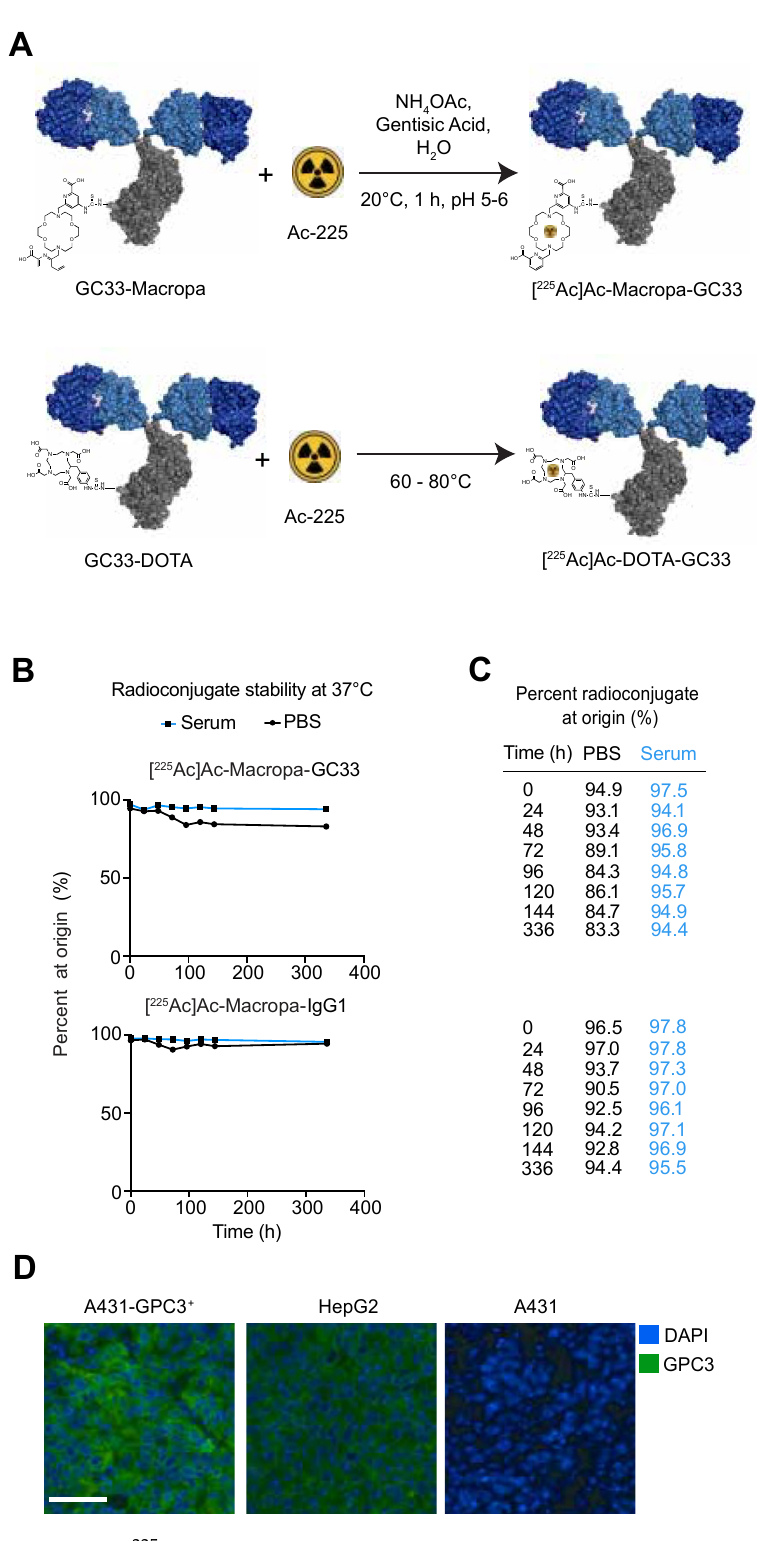
Figure 1. 225 Ac-labeled Macropa radioimmunoconjugates are stable in serum over time. ( A ). Schema for one-step Ac-225 labeling of antibody radioconjugates underscores that, unlike DOTA, Macropa chelation can occur at room temperature. ( B , C ). [ 225 Ac]Ac–Macropa–GC33 and [ 225 Ac]Ac– Macropa–IgG1 are stable in human serum and PBS at 37 °C up to 336 h after radiolabeling as measured by thin-layer chromatography and percent of activity at origin. ( D ). Immunofluorescence staining for GPC3 with fluorescently labeled GC33 (green) and DAPI (blue) counterstain of tumors derived from A431-GPC3 + , HepG2, and A431 (scale bar 50 µm).